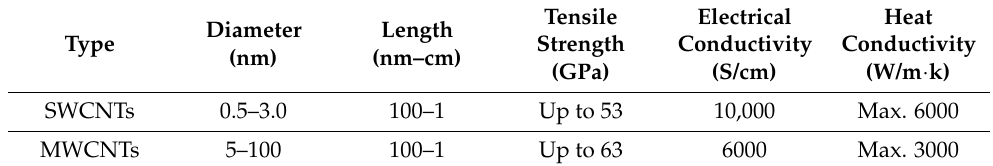
Table 1. Differences between SWCNTs and